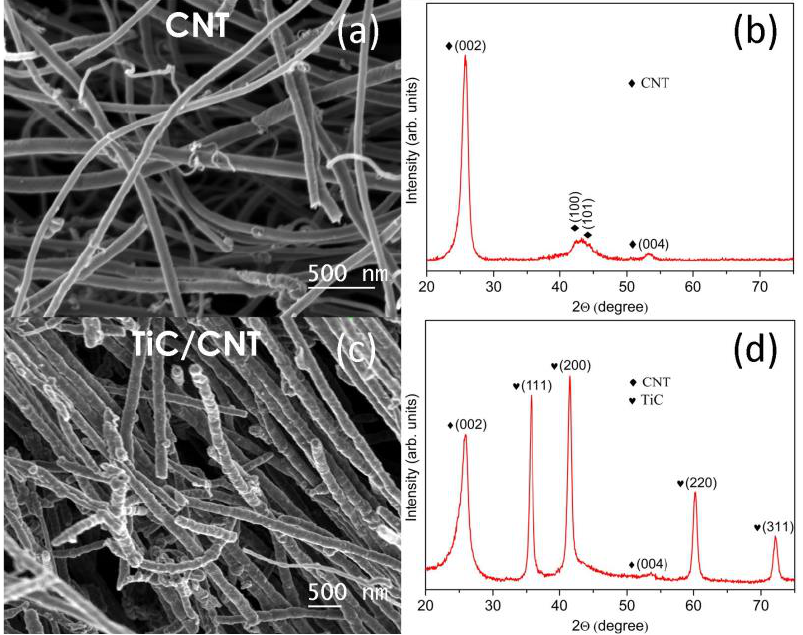
Figure 1. SEM image of pristine CNTs ( a ), TiC/CNT ( b ), XRD of pristine CNTs ( c ), TiC/CNT ( d ).